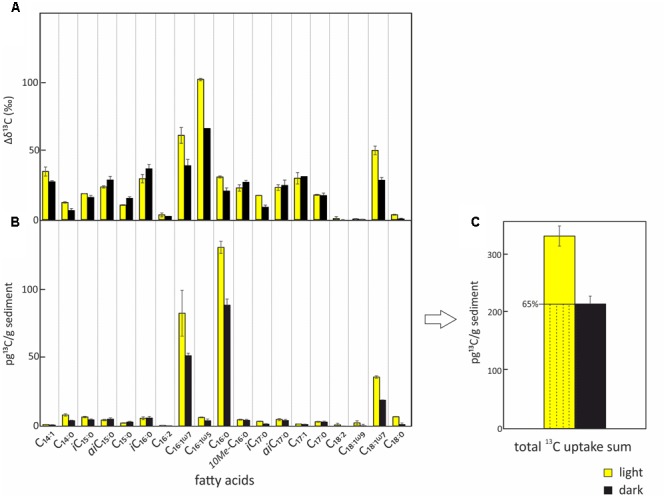
Uptake of 13C-bicarbonate into lipid biomarkers under light and dark conditions. Total uptake of 13C-bicarbonate into fatty acids after incubations under light (yellow) and dark (black) conditions including standard deviations of repeated measurements. (A) Relative change of δ13C in the different bacterial fatty acids over the course of the experiment. (B) Absolute 13C-bicarbonate uptake into the different bacterial fatty acids. (C) Total quantified 13C-incorporation in fatty acids. The total uptake under light conditions which is attributed to chemoautotrophy is indicated by the dashed area.